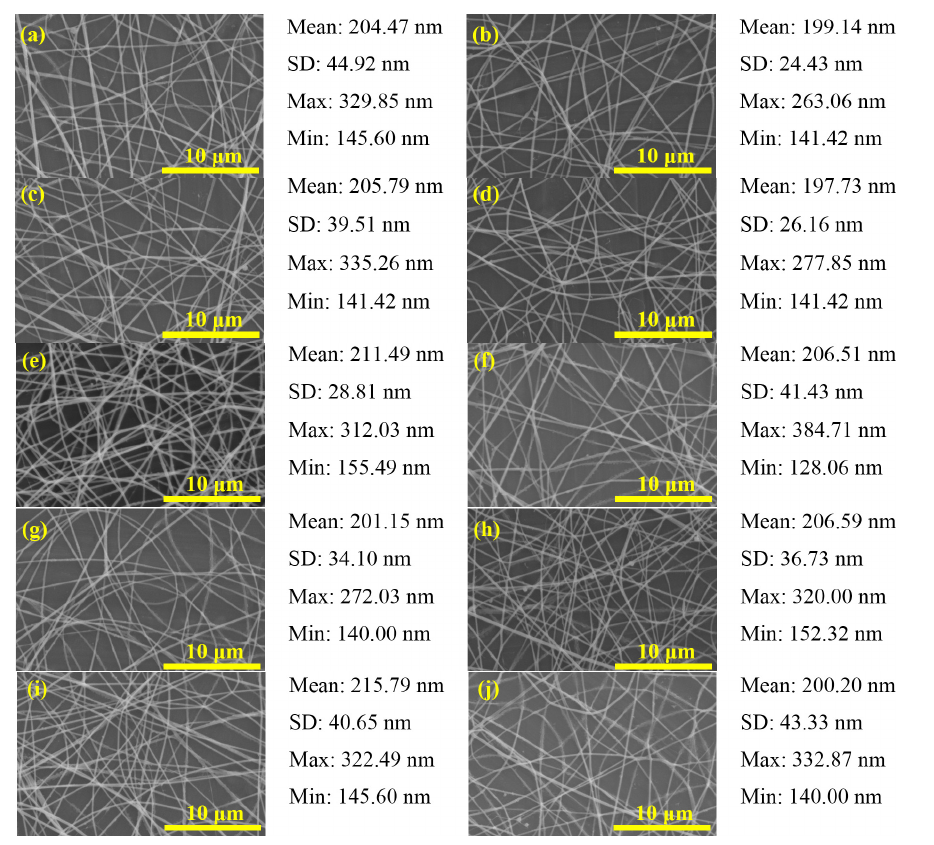
Figure 7. SEM images of PbI 2 /PVP composite fibers produced at different flow rate: ( a ) 0.2; ( b ) 0.4; ( c ) 0.6; ( d ) 0.8; ( e ) 1.0; ( f ) 1.2; ( g ) 1.4; ( h ) 1.6; ( i ) 1.8 and ( j ) 2.0 mL/h (V = 16 kV, L = 1.0